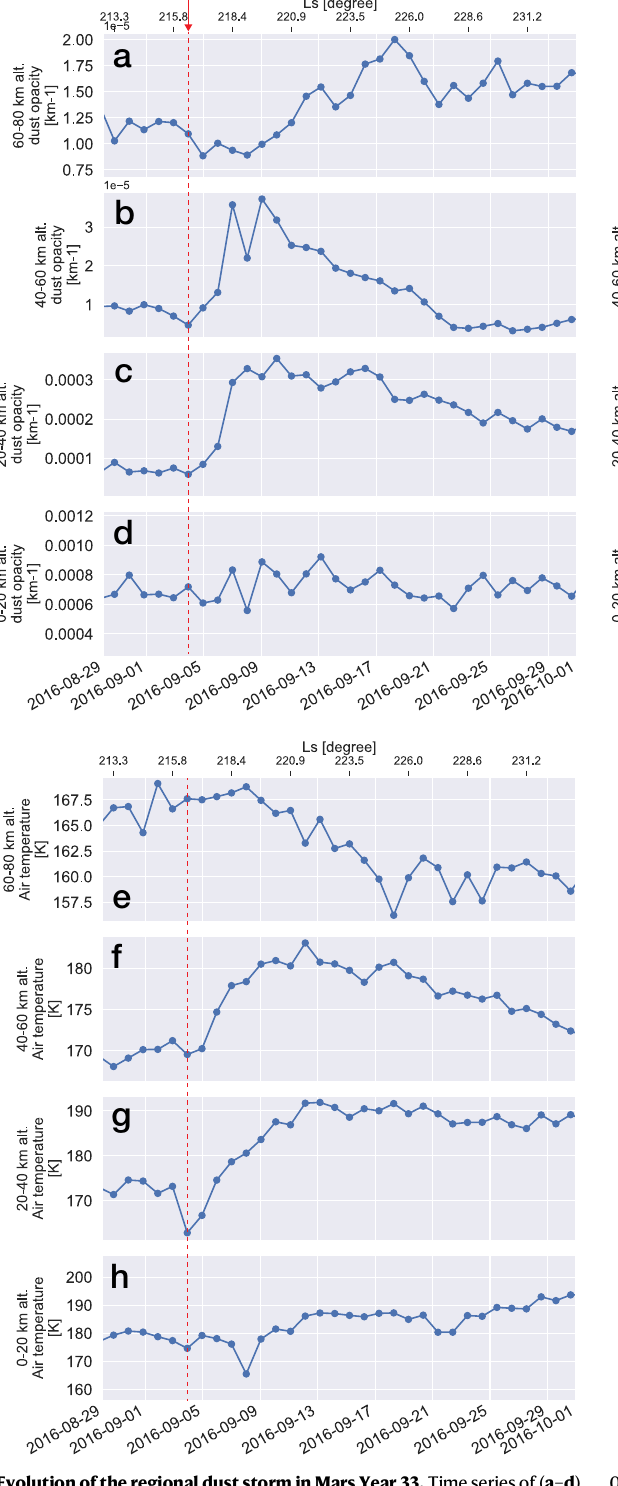
0 – 20km, 20 – 40km, 40 – 60km, and 60 – 80km. Each data point is the average valuesampledatalllatitudesandlongitudeseveryMartianday(localtimeislimited between 11h and 13h). The red dashed lines indicate the dust storm onset